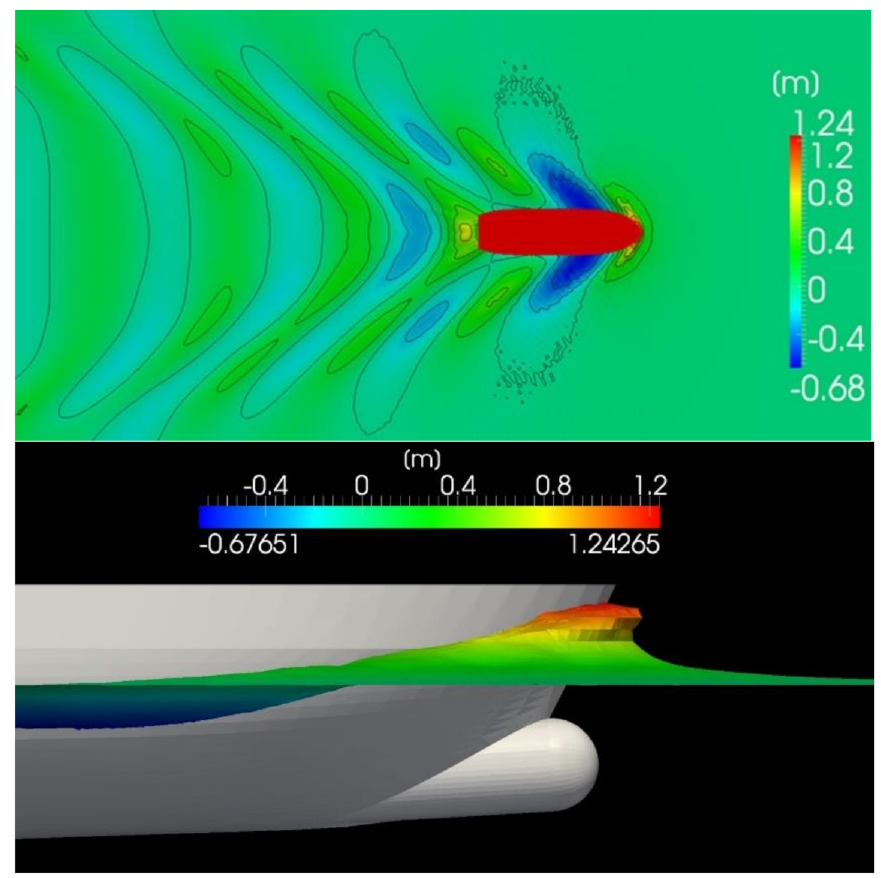
Figure 8. Visualization of the wave system (wave elevation (m)) generated during the movement of a fishing vessel equipped with bulbous bow—overhead view ( top ), wave shape on the bow ( below ).